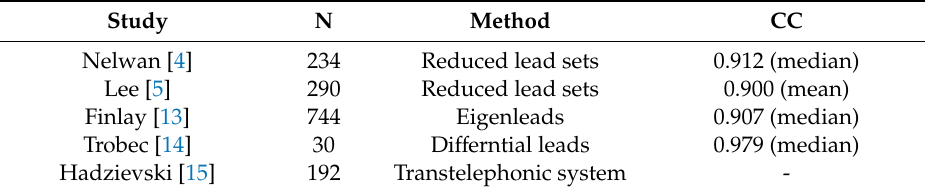
Table 1. Some of the previous 12-lead ECG reconstruction